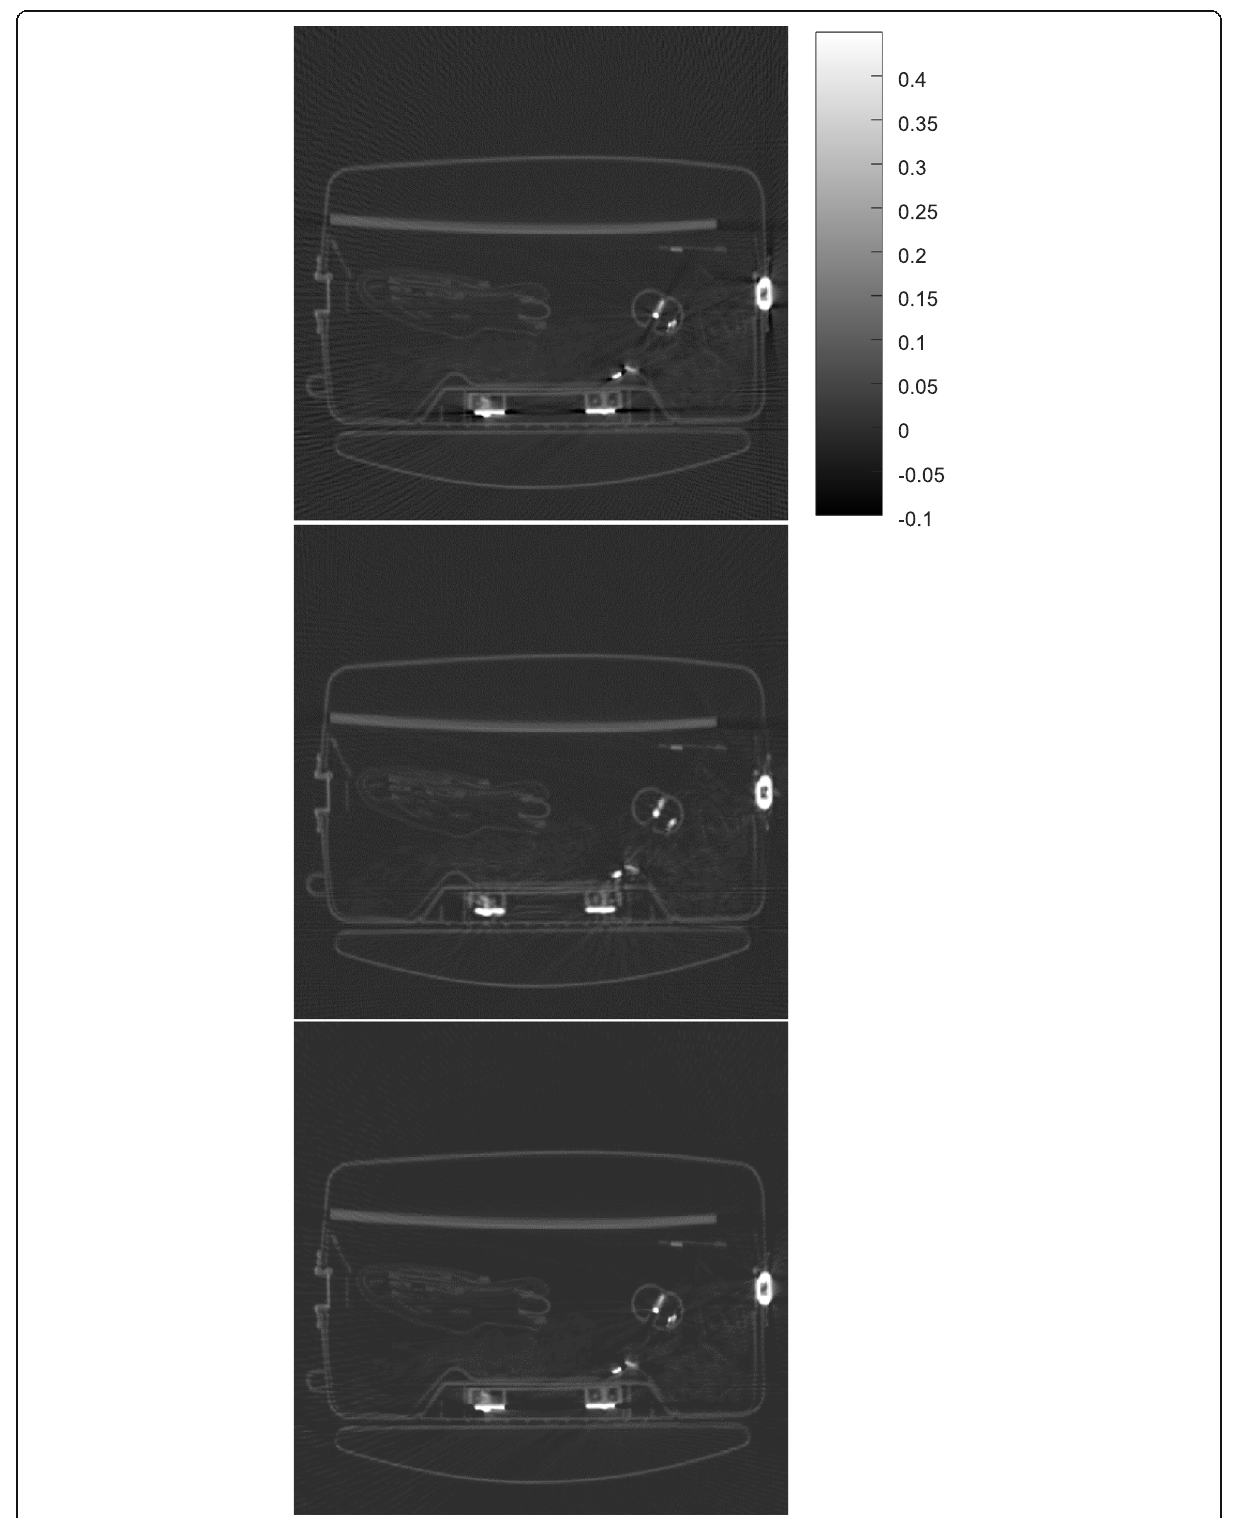
Fig. 3 CT image reconstruction of airport bag #3. Top: the raw FBP reconstruction; Middle: the reconstruction using the proposed algorithm; Bottom: the raw FBP reconstruction with all negative pixel values replaced by